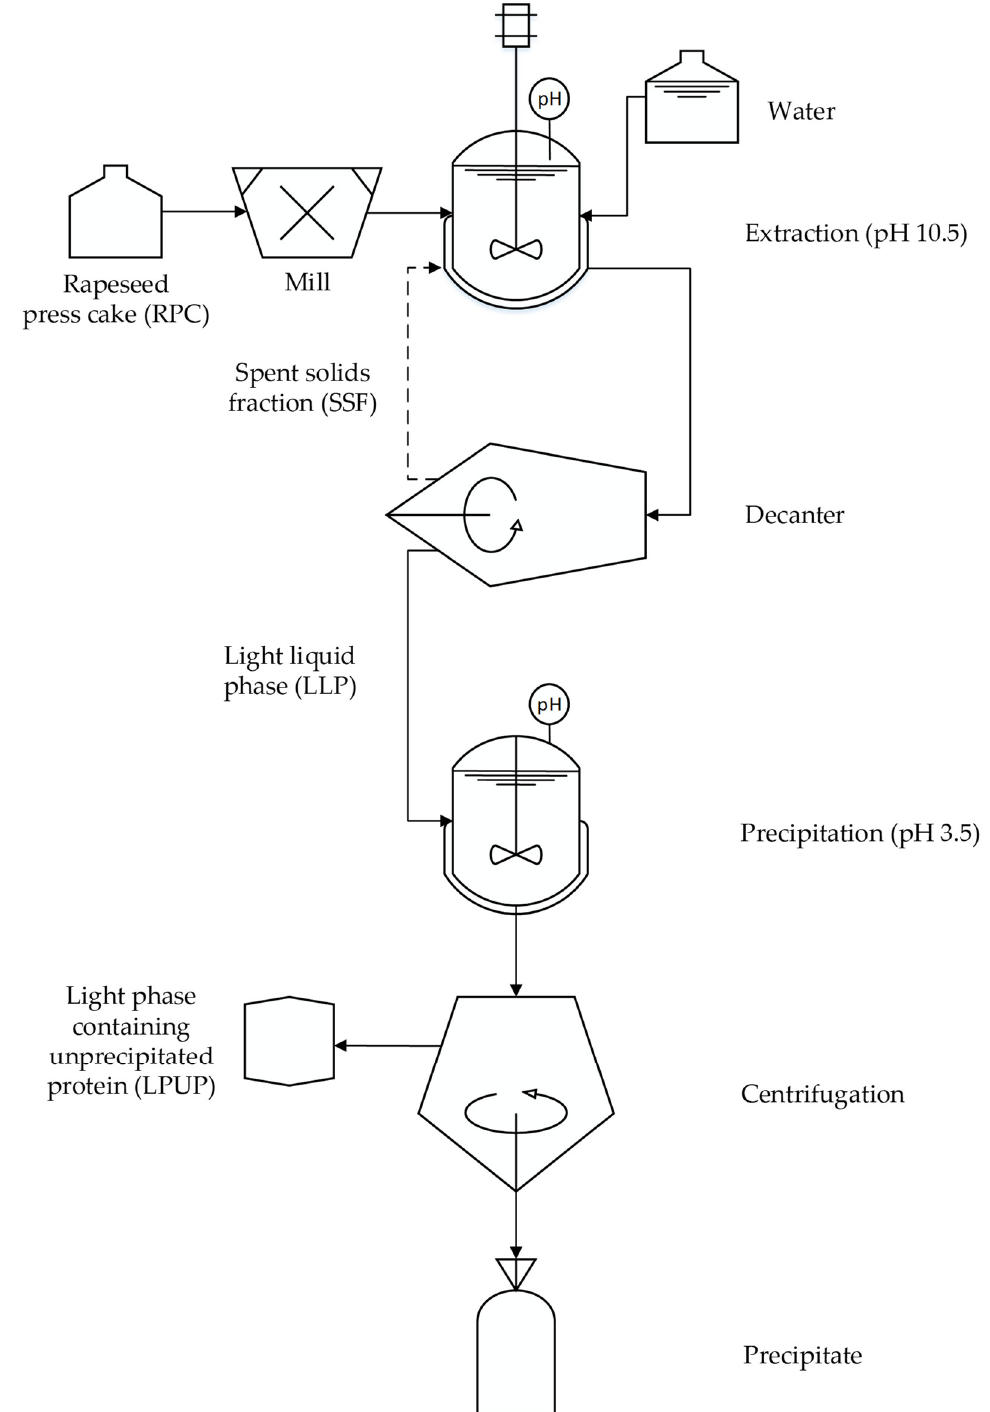
Figure 1. A flowchart of the process used to separate protein from rapeseed press cake. The dashed arrow indicates the recirculation of the spent solids fraction (SSF).